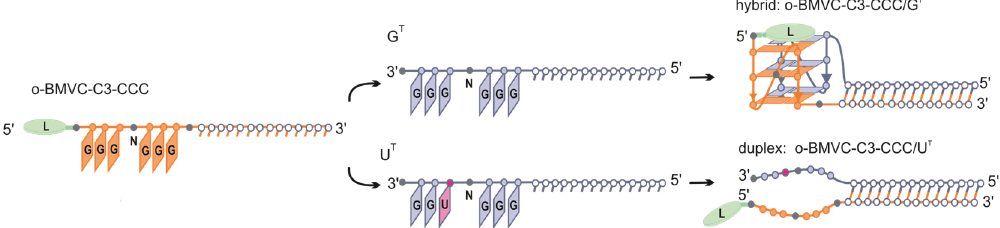
Figure 9. The recognition of G T and U T targets by a model L–CCC oligonucleotide resulting in the formation of a ligand– quadruplex–duplex structural hybrid (L–CCC/G T ) or duplex with long dangling ends (L–CCC/U T ).